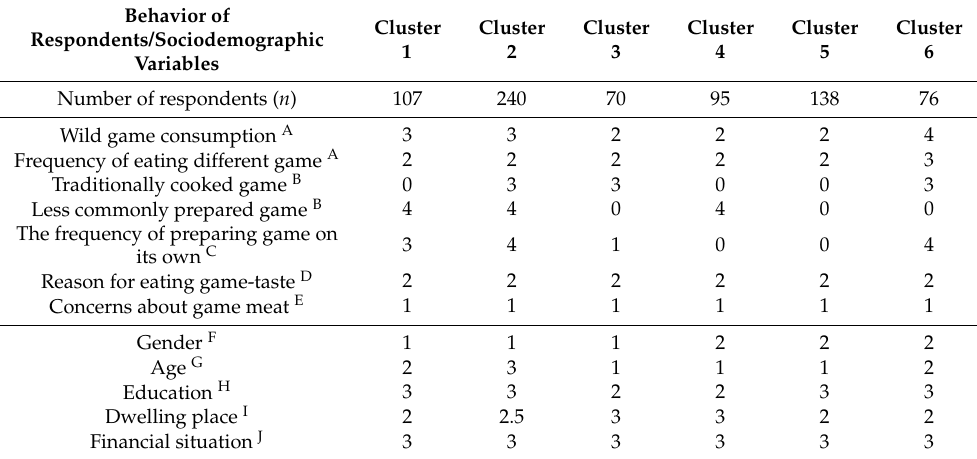
Table 4. Medians of dimensions describing the behavior of respondents and sociodemographic variables in the proposed